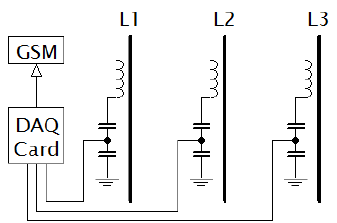
Figure 2. Schema of the single layer inductor based metering